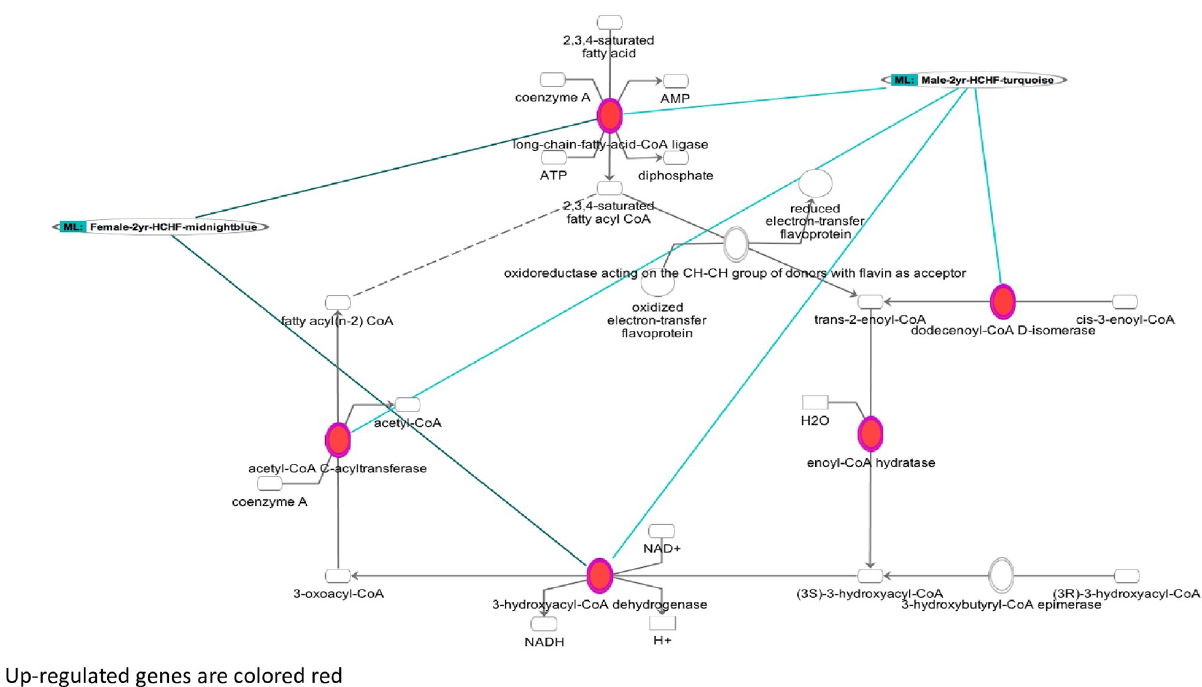
Fig 2. Fatty Acid β -Oxidation Pathway: Overlay of female midnight blue and male turquoise 2-year HCHF modules. Red fill indicates genes positively correlated with lesion burden. Green lines indicate genes from female and male modules respectively.